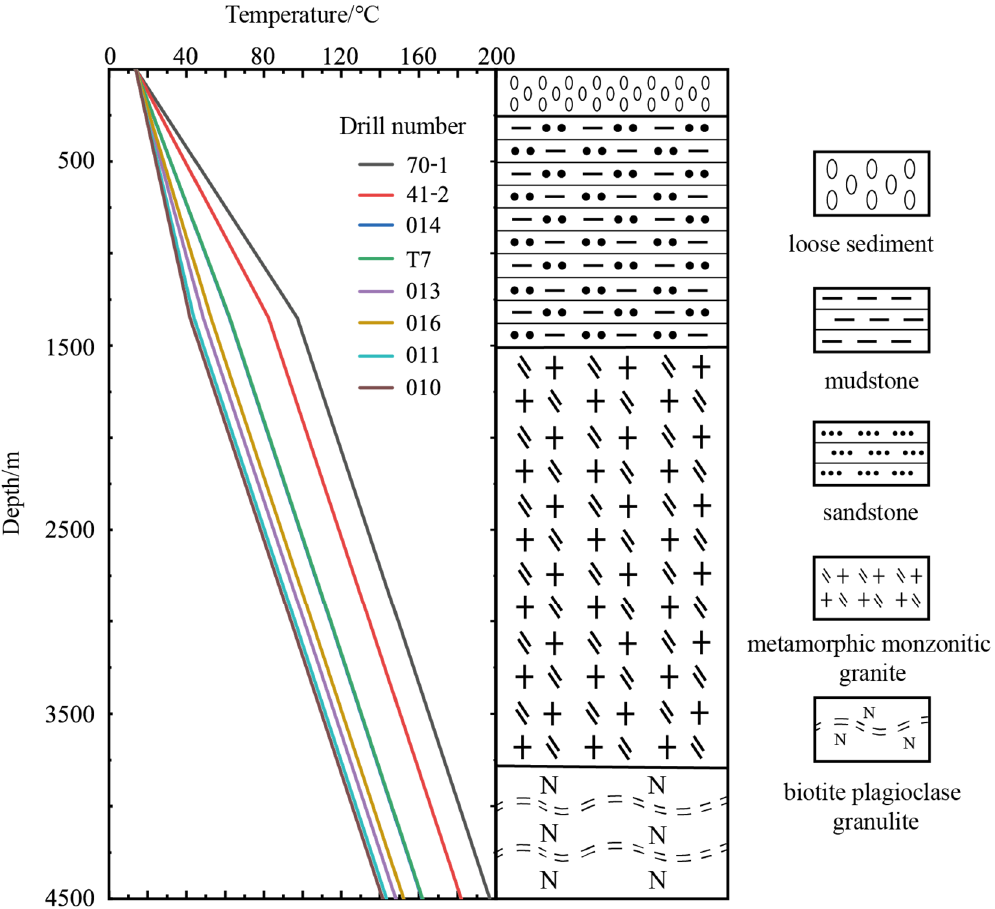
Figure 2. Distributions of rock lithologic and temperature in the depth profile of the borehole in the Matouying uplift area.